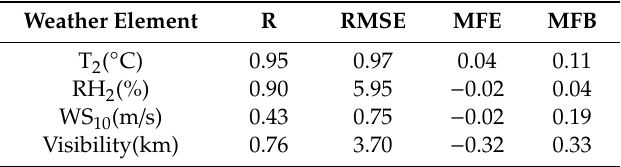
Table 1. Correlation coe ffi cient (R), root mean square error (RMSE), mean fractional error (MFE), and mean fractional bias (MFB) of the multi-winter (2013–2017) mean 3-hourly T 2 , RH 2 , WS 10 , and VIS simulated by WRF-Chem model compared to the observation in Jiangsu